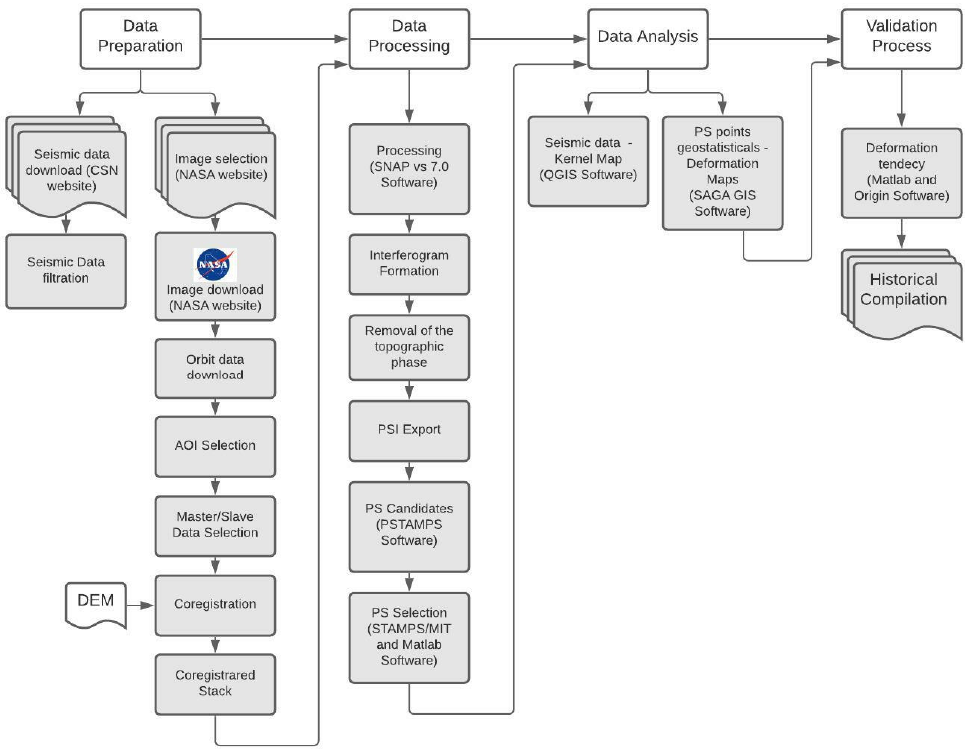
Figure 2. Technical flow chart to represent the methodological process followed in this